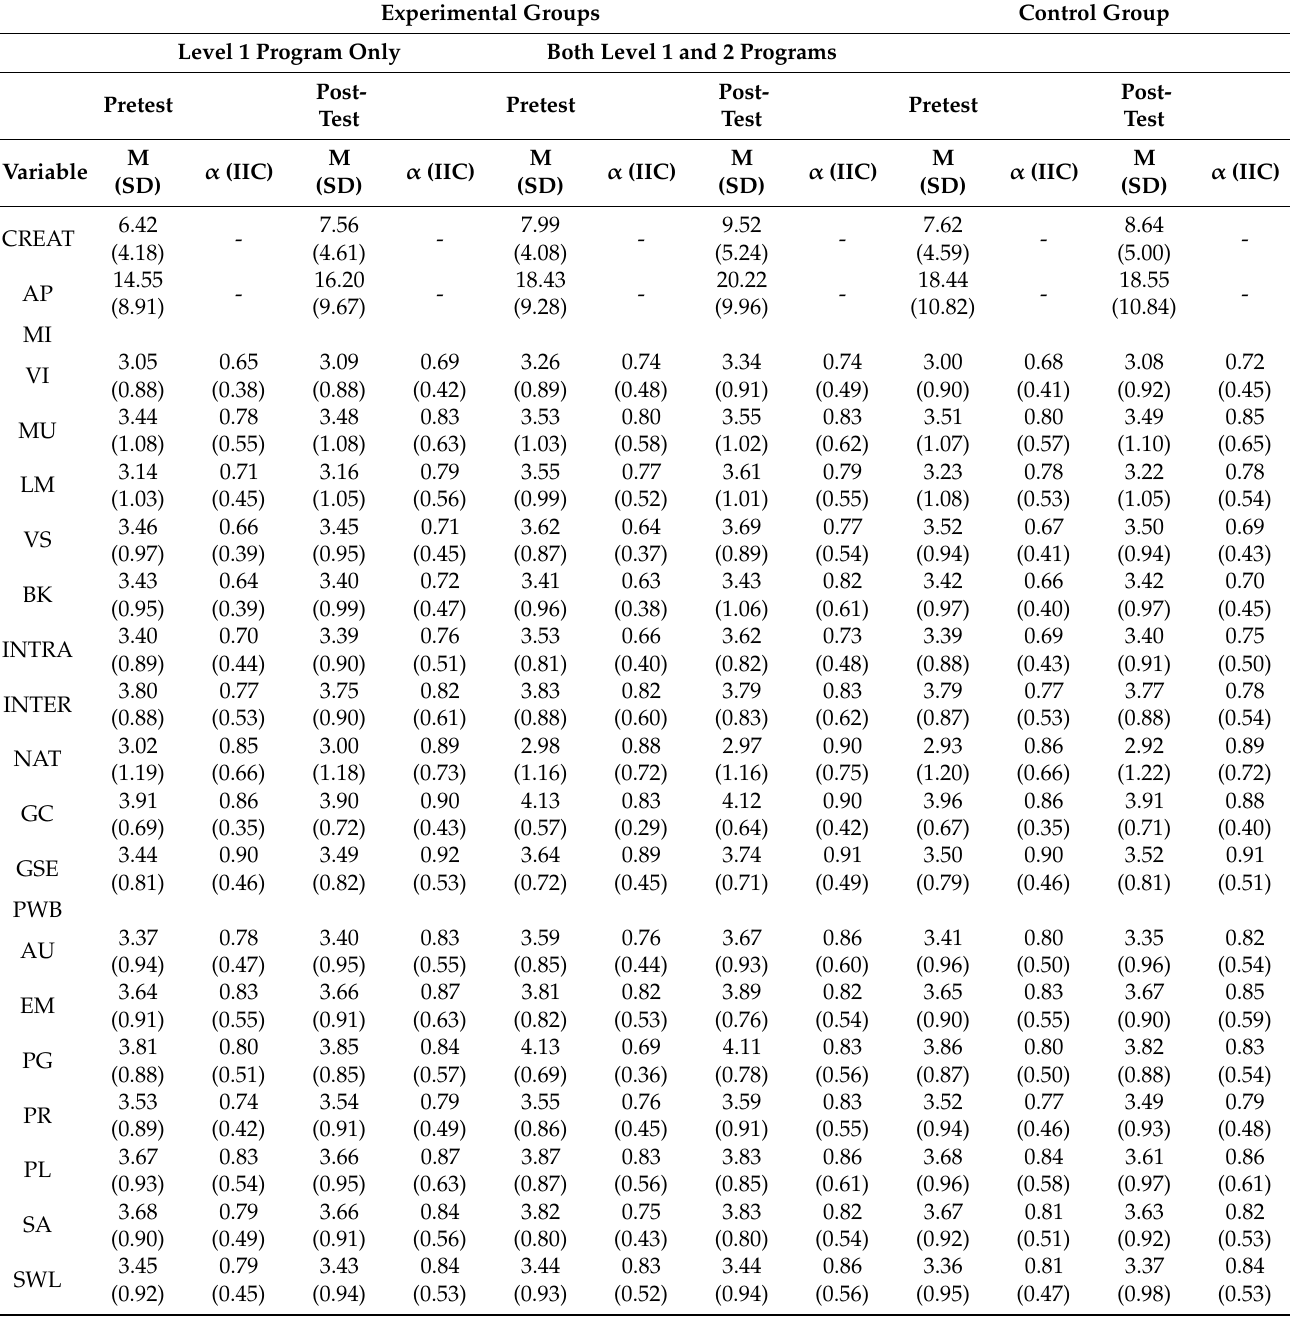
Table 2. Descriptive statistics and reliabilities of all outcome variables in Level 1 program only, both Level 1 and 2 programs, and control